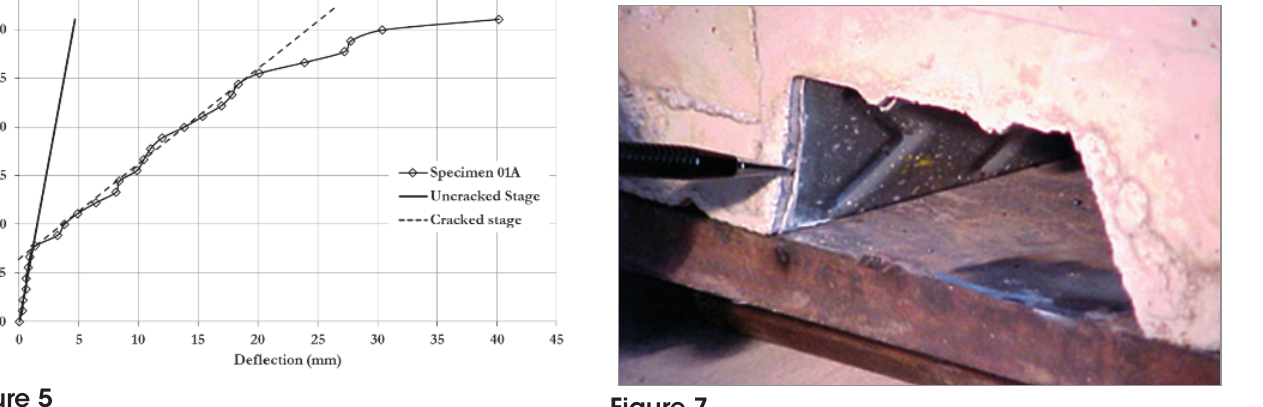
Figure 7 End-slip between the steel sheeting and the